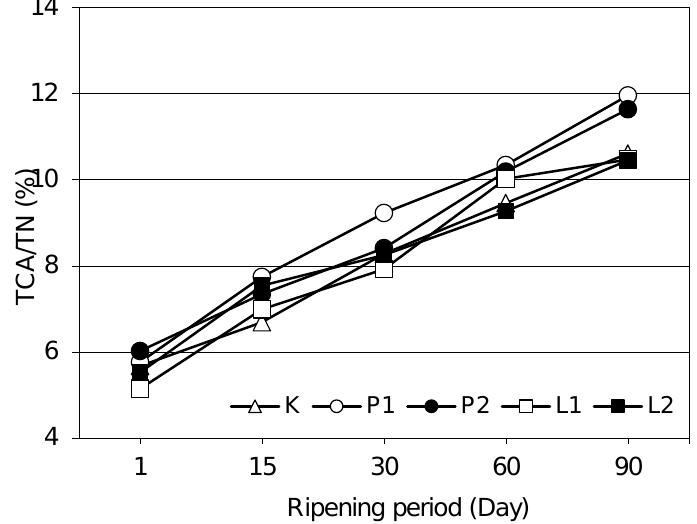
Figure 1. Ripening indices trichloroacetic acid soluble nitrogen (TCA-SN/TN) of White cheeses during ripening.